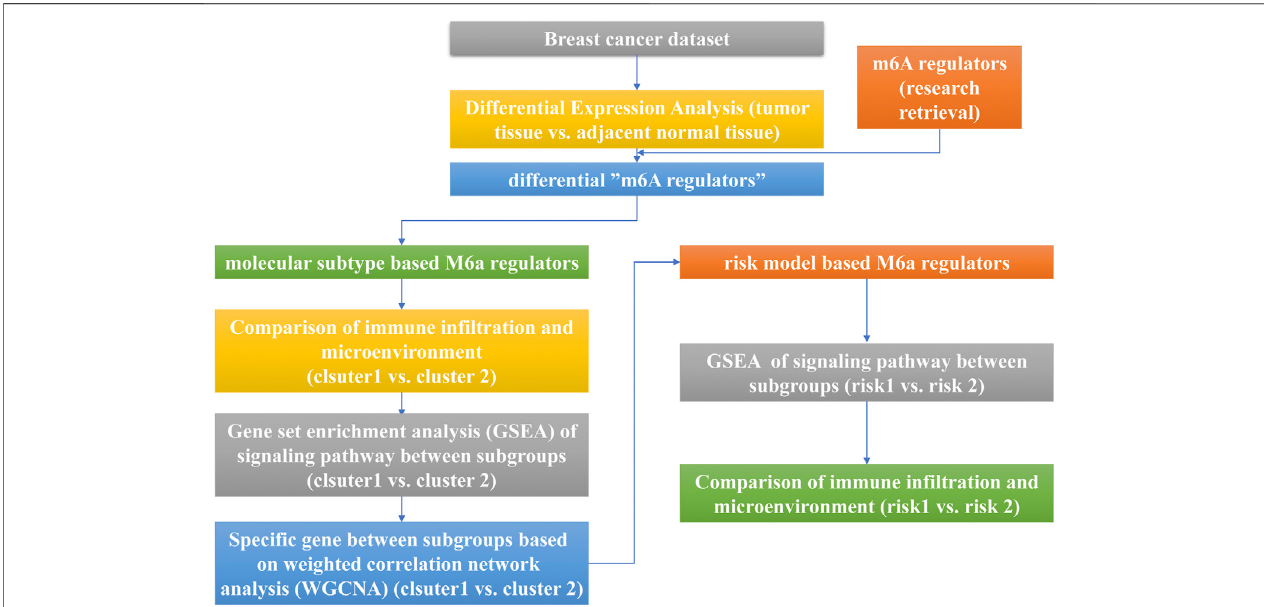
FIGURE 1 | The fl ow chart of the study design and